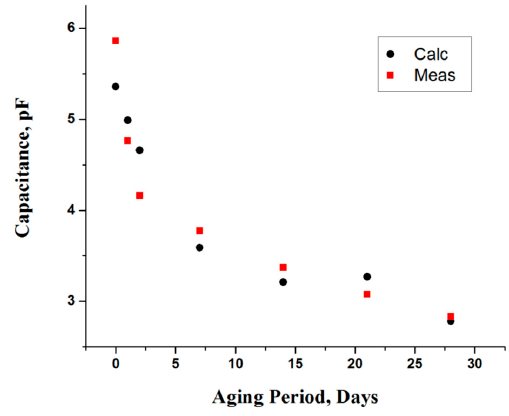
Figure 9. Capacitance (C 1 ) of cell membrane as a function of aging period.